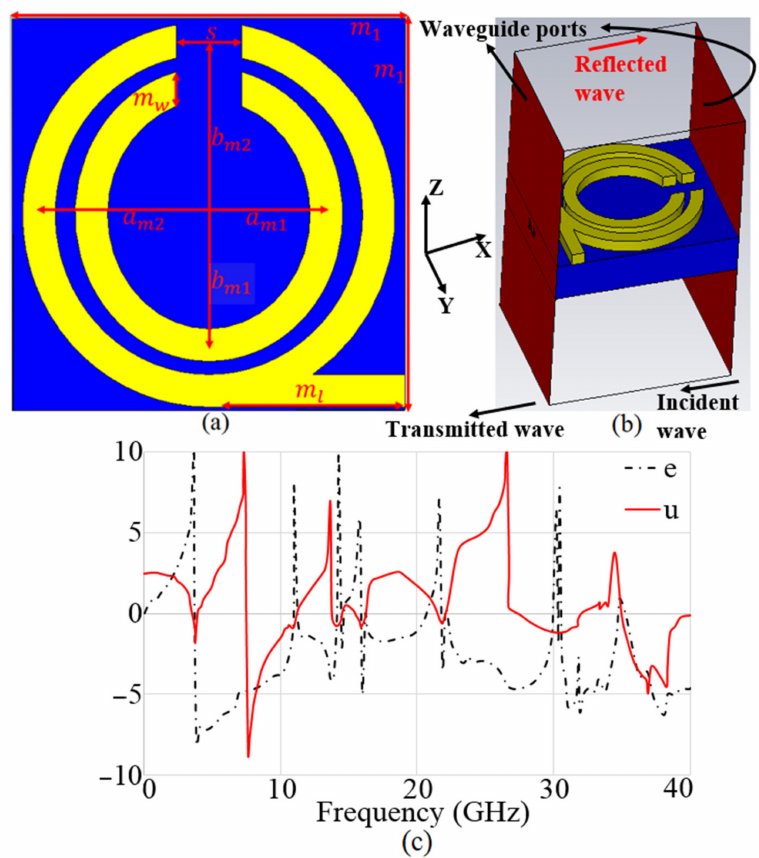
Figure 10. MTM unit cell structure: ( a ) 2D view, ( b ) 3D view and ( c ) effective permittivity ( e ) and permeability ( u ).